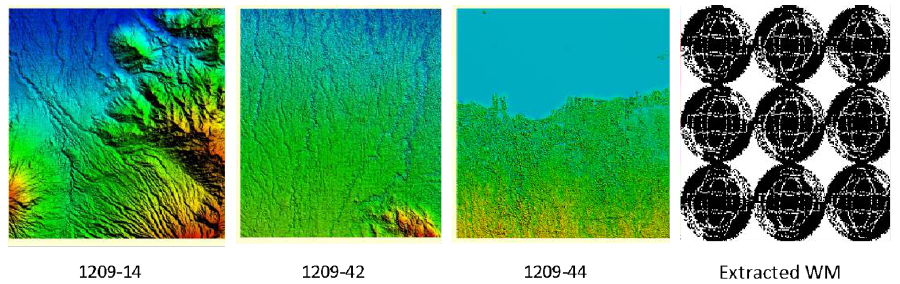
Figure 13. Results of watermarking using a combination of 2D DWT and 2D DCT algorithms; 100% watermark image extraction was realized with 2D DWT and 2D DCT. However, this extraction is not superior to that of DCT only because the distortion to the elevation value is quite large; thus, some extractions reaching 1160 m apply equally to all image areas.